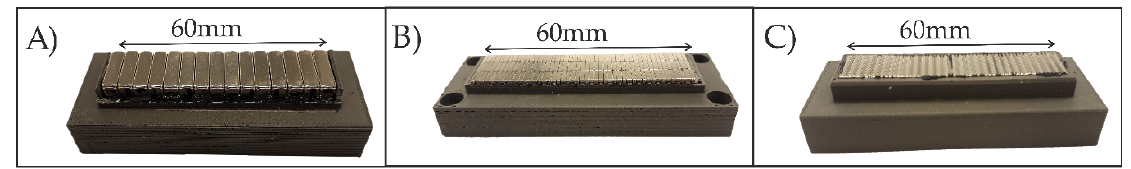
Figure 5. Halbach array assemblies made using ( A ) 15 × 4 × 4 mm; ( B ) 5 × 1 × 1.5 mm; ( C ) 12 × 1 × 2.75 mm/12 × 2 × 1 mm magnets.